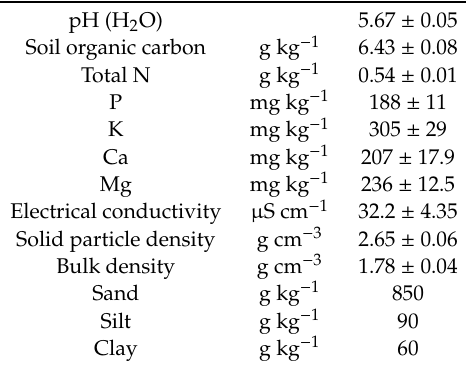
Table 1. Basic soil physical and chemical properties (means ± standard deviation).